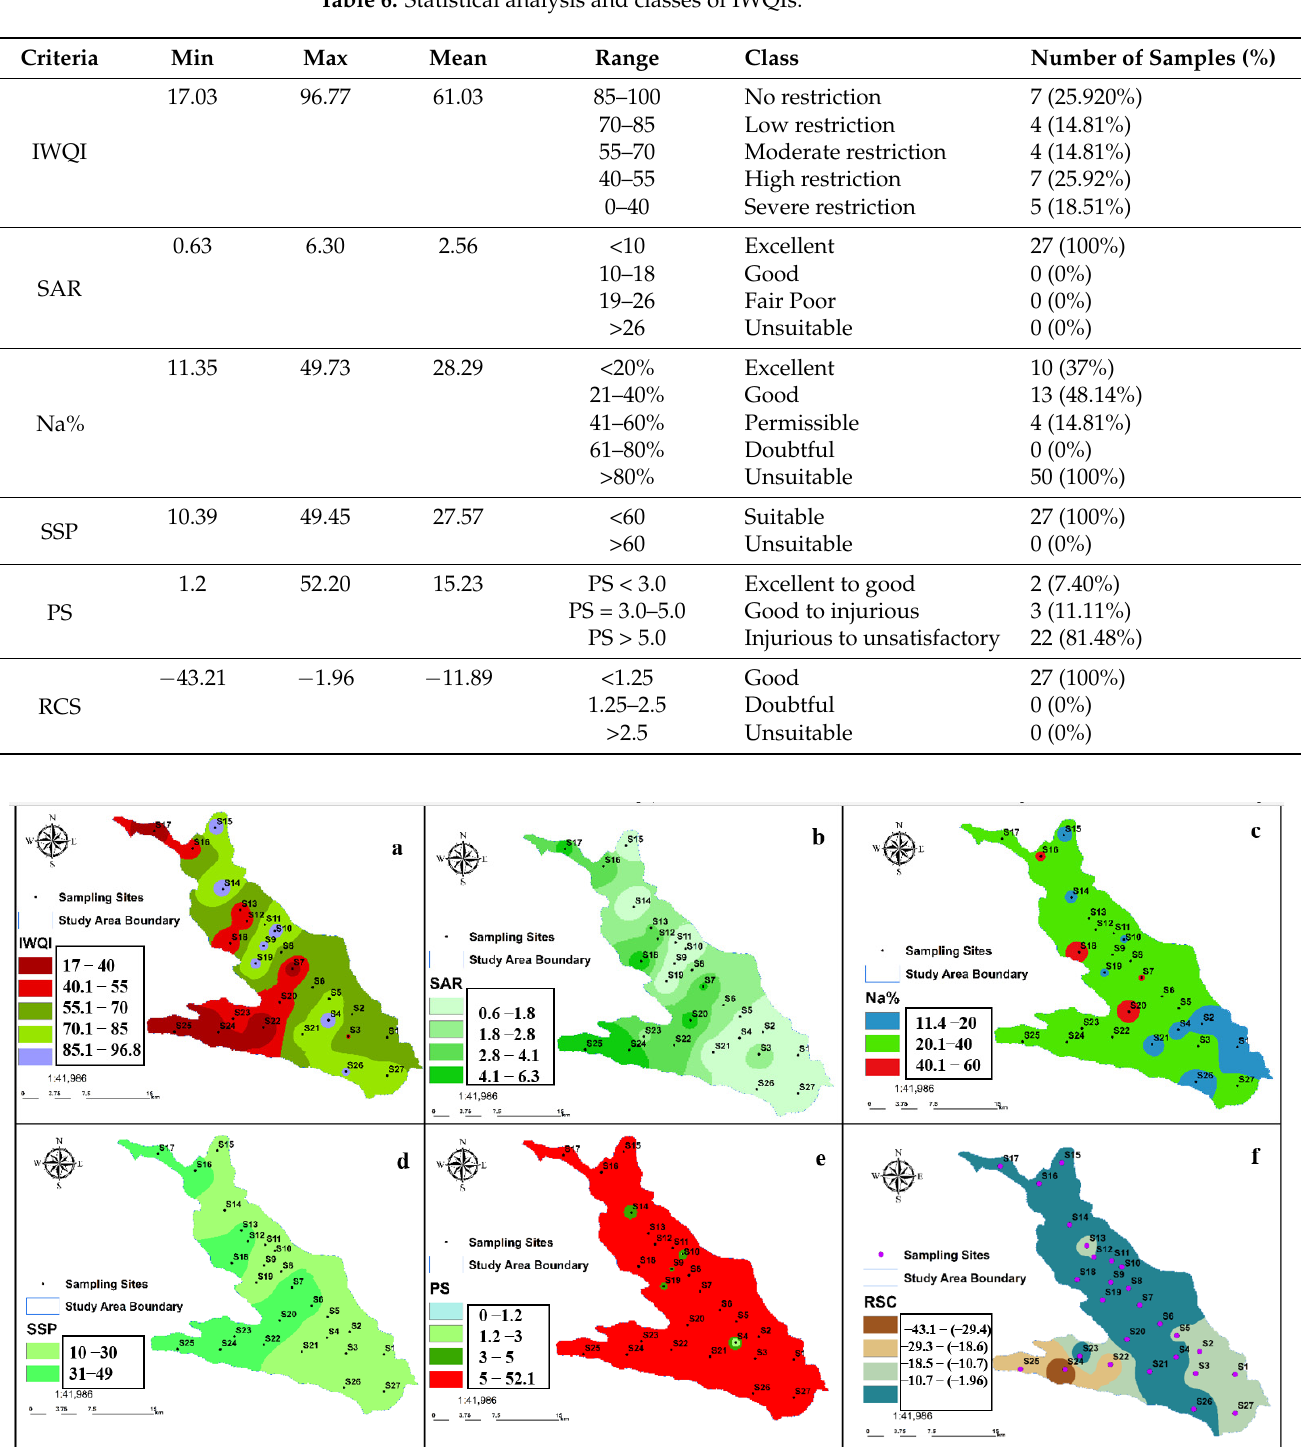
Table 6. Statistical analysis and classes of IWQIs.